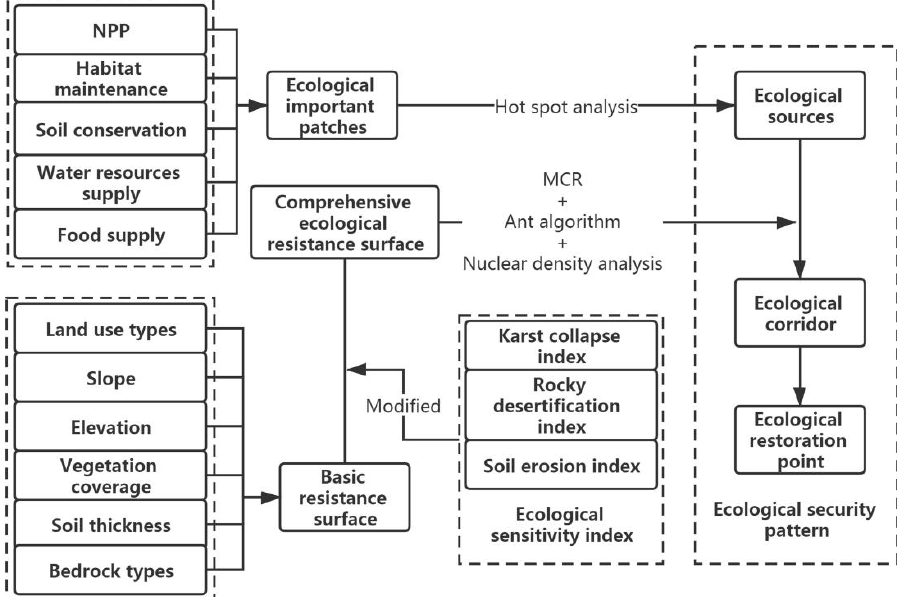
Figure 2. The methodology framework of the